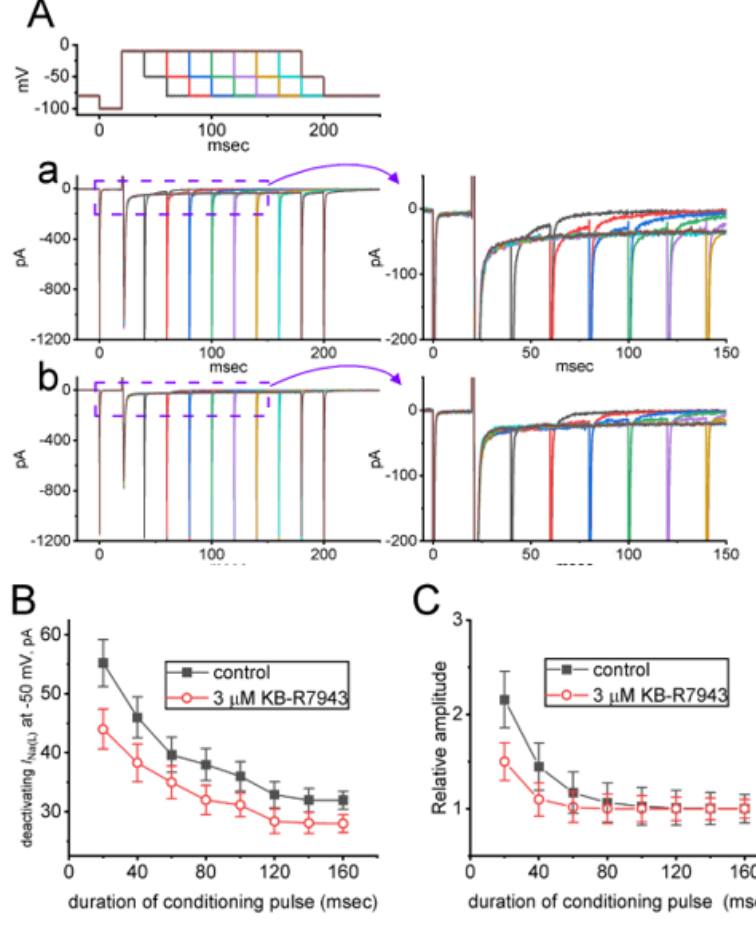
Figure 5. Effect of KB − R7943 on both recovery of I Na(L) ( A ) and I Na(L) magnitude evoked by the envelope − of − tail test ( B ) seen in GH 3 cells. ( A ) Exemplar current traces taken during the control period (a, absence of KB-R7943) and with presence of 3 µ M KB − R7943 (b). Different colors represent the specific current trace evoked by the voltage pulse with increasing duration at the level of − 10 mV. The panels shown on the right side denote the expanded records from purple dashed boxes with solid curve arrows on the left side for better illustrations. ( B ) Relationship of the duration of depo- larizing pulse versus the I Na(L) amplitude at − 50 mV acquired in the absence (filled black squares) and presence (open red circles) of 3 μM KB − R7943 (mean ± SEM; n = 7 for each point). Current amplitude was measured at the end of voltage pulse at the level of − 50 mV, and the absolute value of current amplitude is illustrated. ( C ) KB − R7943 − mediated changes in I Na(L) amplitude evoked by the envelope − of − tail test (mean ± SEM; n = 7 for each point). The relationships of the pulse duration versus the relative amplitude of I Na(L) are illustrated with or without cell exposure to 3 μM KB − R7943. The relative amplitude appearing at the y − axis was measured in situations where I Na(L) amplitude at the end of depolarizing pulse from −1 00 to − 10 mV was divided by the tail current at the end of the voltage step taken following a return to − 50 mV. The decaying rate of I Na(L) evoked during the enve- lope − of − tail occurred in a single exponential function.